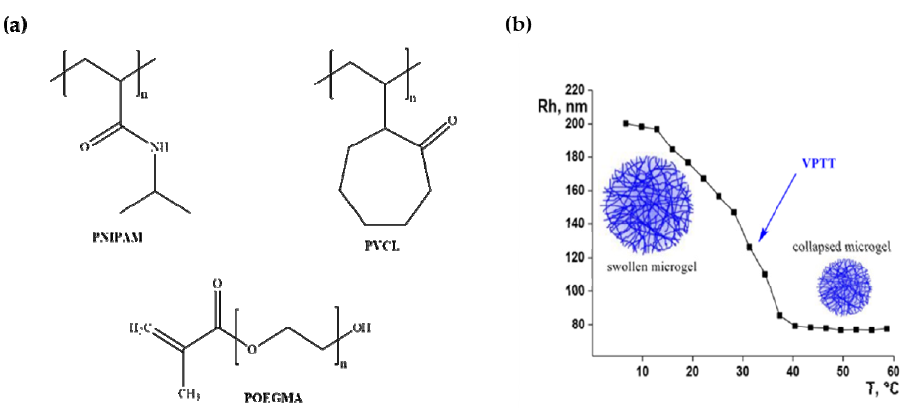
Figure 5. ( a ) Structures of thermos-responsive polymers. ( b ) Illustration of volume phase transition of PNINAM.